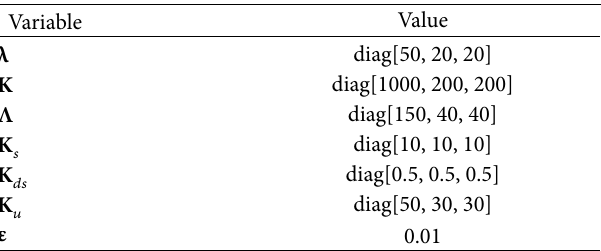
Table 3: The control parameters of three types of